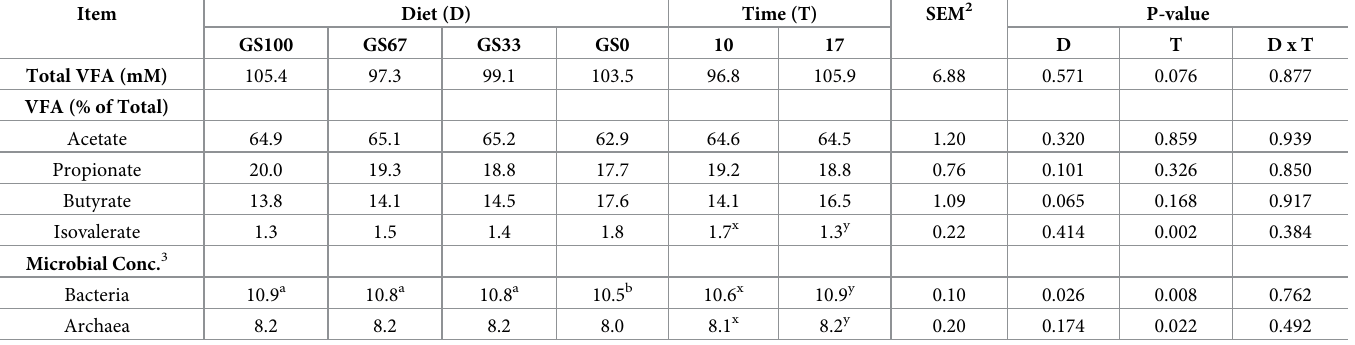
Table 2. Ruminal fermentation products and microbial concentrations measured in dairy cows after 10 or 17 days of feeding different proportions of grass silage (GS) and/or maize silage (MS) 1 .